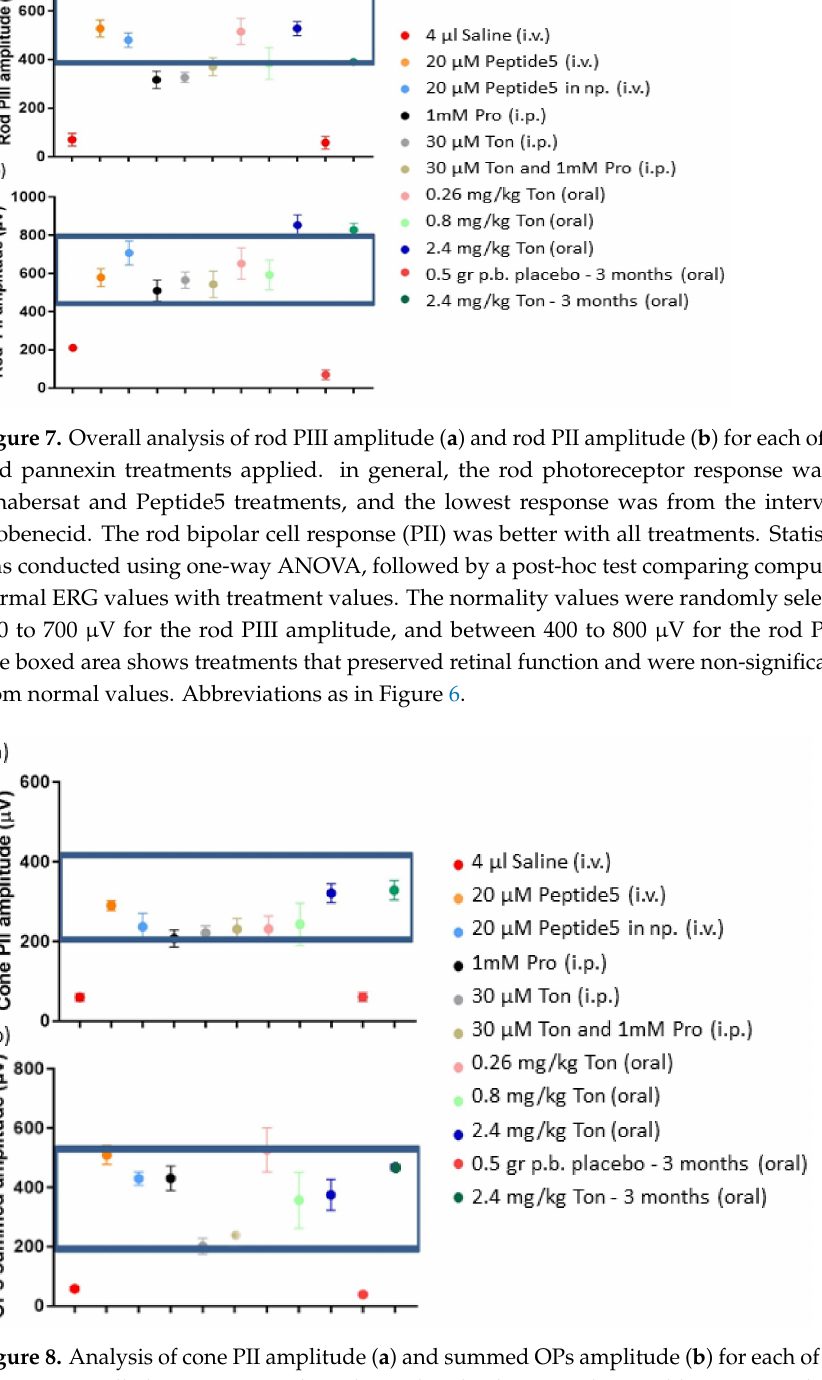
Figure 8. Analysis of cone PII amplitude ( a ) and summed OPs amplitude ( b ) for each of the treatment groups. Overall, the cone PII results indicate that the drugs used were able to protect the retina. How- ever, the combination of tonabersat and probenecid or tonabersat alone delivered by intraperitoneal injection was less protective to the amacrine cells, which generate the OPs during signal transduction in the inner retina, than any of the other routes of delivery or probenecid alone. Statistical analysis was conducted using one-way ANOVA, followed by a post-hoc test comparing computer-generated normal ERG values with treatment values. The normality values were randomly selected between 200 to 400 µ V for the cone PII amplitude, and between 200 to 500 µ V for the summed OPs. The boxed area shows treatments that preserved retinal function and were non-significantly different from normal values. Abbreviations as in Figure